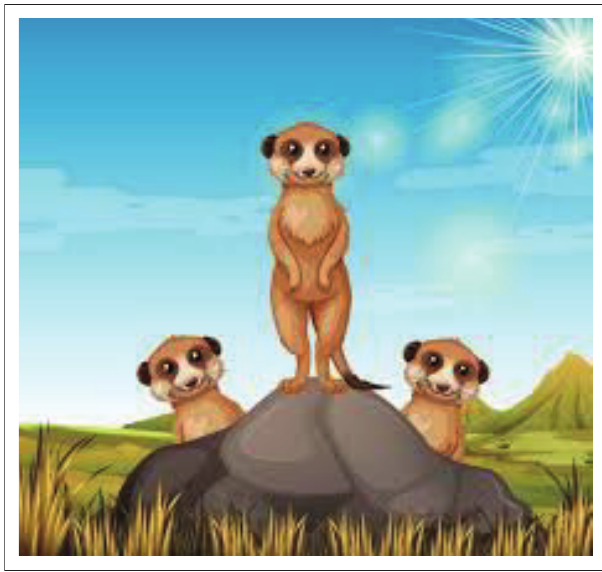
FIGURE 2: A framework for teacher